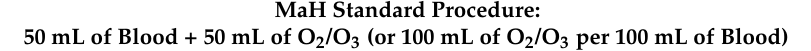
Table 2. Standard procedure of major autohemotherapy MAH [9]. MaH Standard